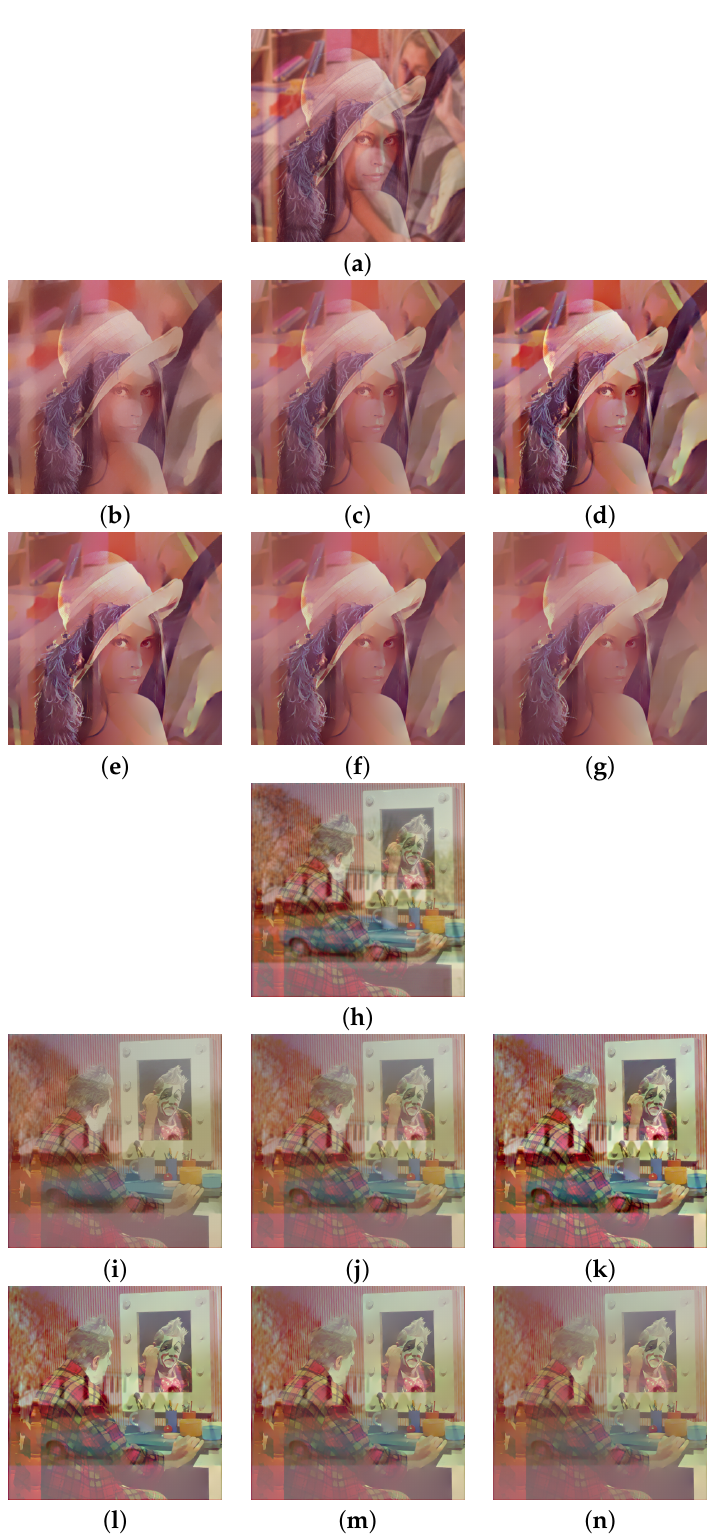
Figure 5. Reflection suppression results for synthetic glass images with w = 0.5. ( a , h ) Input images. ( b , i ) The results of algorithm [2]. ( c , j ) The results of algorithm [3]. ( d , k ), ( e , l ), ( f , m ), and ( g , n ) are results of the proposed algorithm with N = 1,2,3,4,